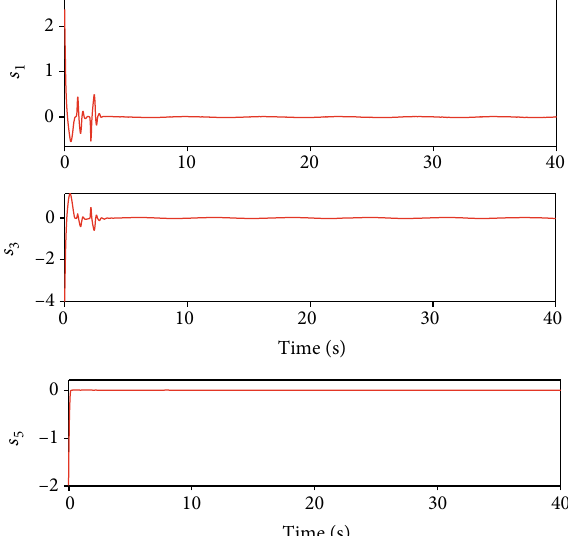
Figure 8: Position sliding surfaces.